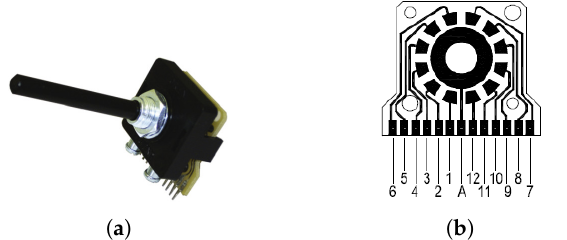
Figure 2. Schematic and assembled unit of a 30 degree indexing, 12 way unipolar switch: ( a ) PT-6015